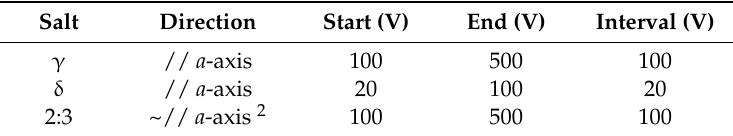
Table 3. Conditions in electrical resistivity measurements. 1